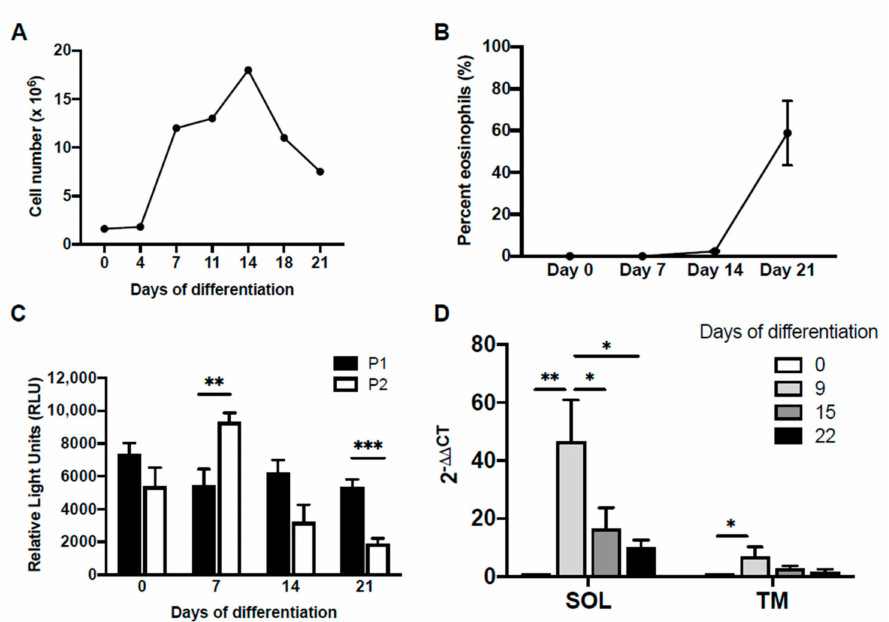
Figure 2. Differential promoter activity during IL-5-dependent differentiation of primary eosinophils from human cord blood-derived CD34 + cells. CD34 + progenitors were first cultured in suspension in SCF, FLT-3, TPO, and GM-CSF for 4 days, followed by only IL-3 and IL-5 to induce differentiation to the eosinophil lineage. ( A ) Cell proliferation and ( B ) percentage of mature eosinophils in culture determined on differential counts using Fast Green/Neutral Red staining is shown. ( C ) Changes in differential promoter activity during eosinophil differentiation were determined by transiently transfecting differentiating cells on days 0, 7, 14, and 21, with IL-5R α P1 or IL-5R α P2 luciferase promoter reporter constructs with a pRL-CMV expression vector as an internal control for transfection efficiency. Promoter activities were measured 6 h post-transfection. Raw measurements in relative light units were first normalized by the dual luciferase method followed by subtraction of background luciferase activity (reading from promoterless vector control). Data are shown as mean relative light units above background for 2–4 independent experiments. SD, standard deviation. ( D ) Quantitative real-time PCR was performed to measure mRNA levels of the IL-5R α soluble and transmembrane splice variants during differentiation. Data are shown as fold changes in mRNA levels over day 0 for one representative experiment. SD, standard deviation. * p < 0.05 ** p < 0.01 *** p <